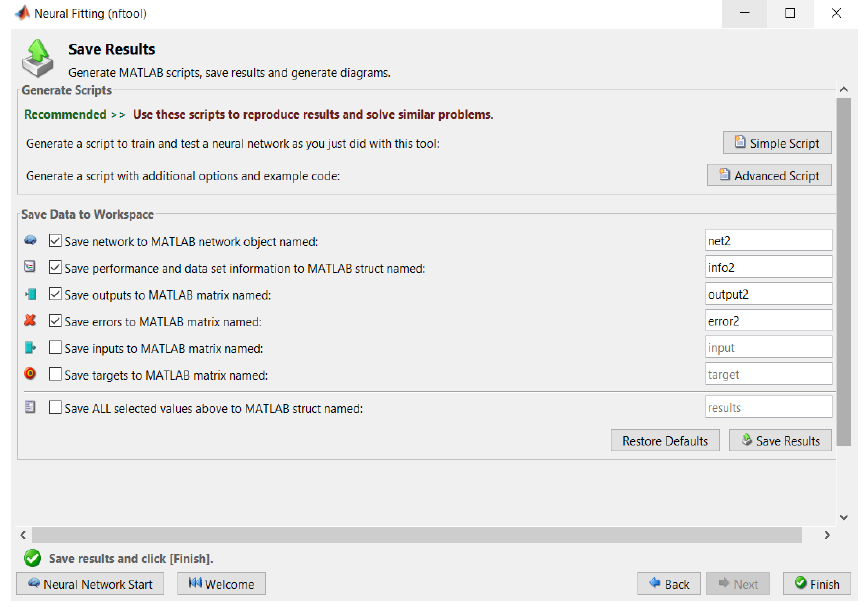
Figure 6. Structure of neural network.